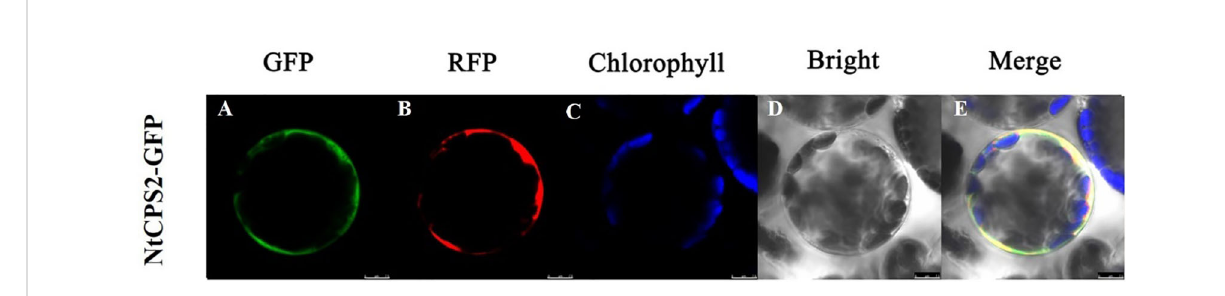
FIGURE 2 Subcellular location of NtCPS2 in tobacco epidermal cells. (A) Green fl uorescence of 35S::NtabDOG1L-T-GFP; (B) Red fl uorescence of 35S:: NtabDOG1L-T-GFP; (C) Chlorophyll fl uorescence; (D) bright- fi eld images; (E) merged images. Bars = 7.5 m